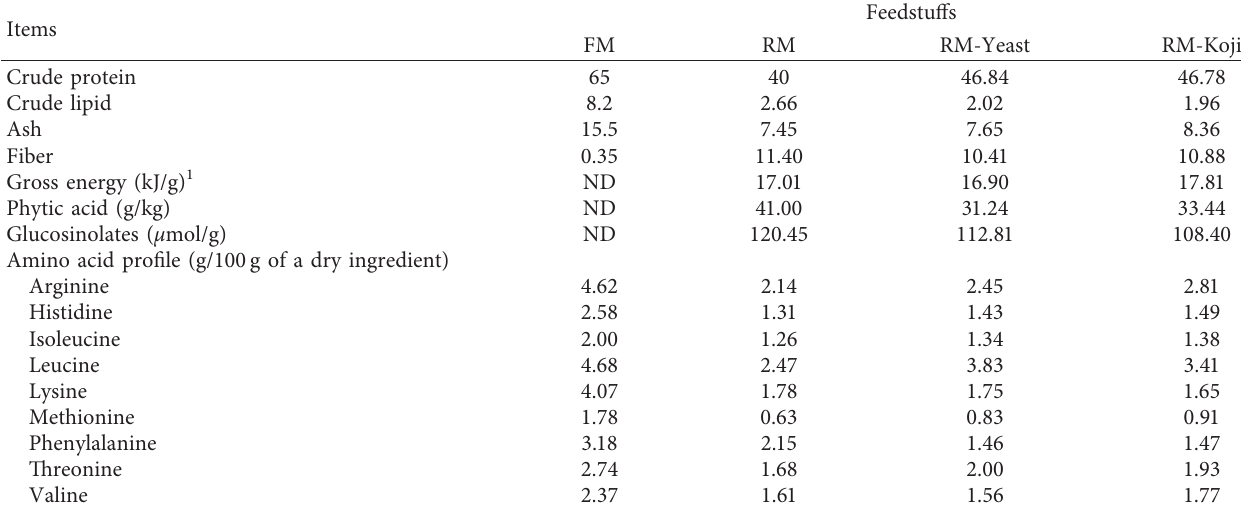
Table 2: The chemical composition and amino acids’ profile of tested